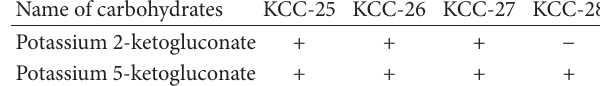
Table 1: Biochemical characterizations of isolated strains by API 50 CHL